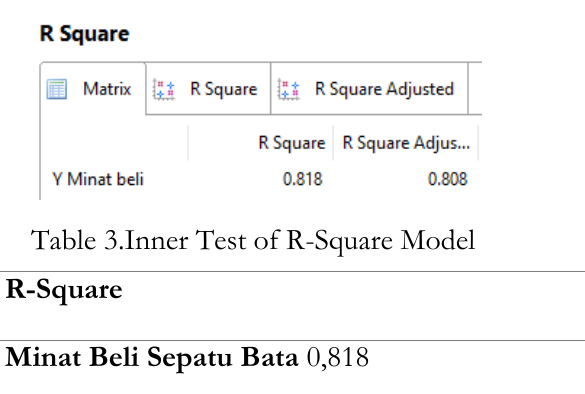
Figure 3. Figures of all constructs that meet the reliable criteria. Composite reliability values above 0.70 and AVE above 0.50 are declared valid, but otherwise the results are invalid.